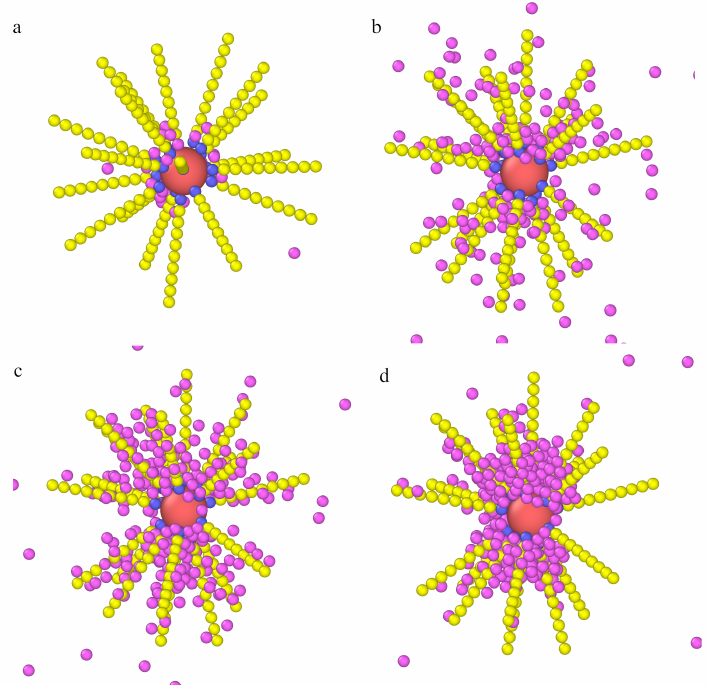
Figure 11. Examples of the equilibrium configurations of the hedgehog-like particles immersed in fluids of densities ρ 0 = 0.0001 ( a ) and 0.001 ( b – d ) for different models: ( a , b ) model M2, ε Ps = 1.5 ε , ( c ) model M2, ε Ps = 3.0 ε , and ( d ) model M2a, ε Ps = 3.0 ε . Other parameters: σ c = 4 σ , f = 20, M = 10. The red sphere represents the core, blue spheres correspond to bonding segments, and yellow spheres and pink spheres represent the remaining segments and fluid particles P,